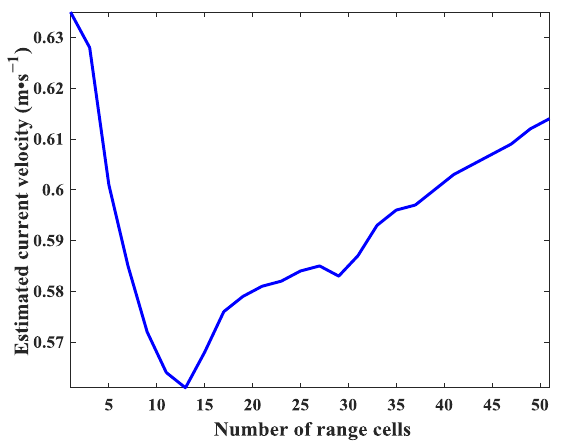
Figure 10. Curve of the estimated sea surface current velocities for averaging different spatial scales.